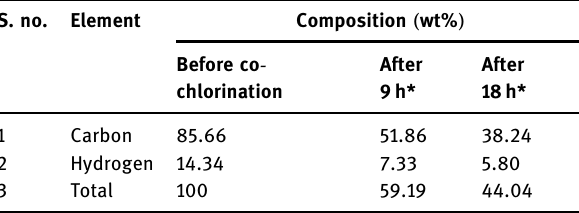
Table 3: Weight percent of C and H in LDPE - para ffi n solution S. no. Element